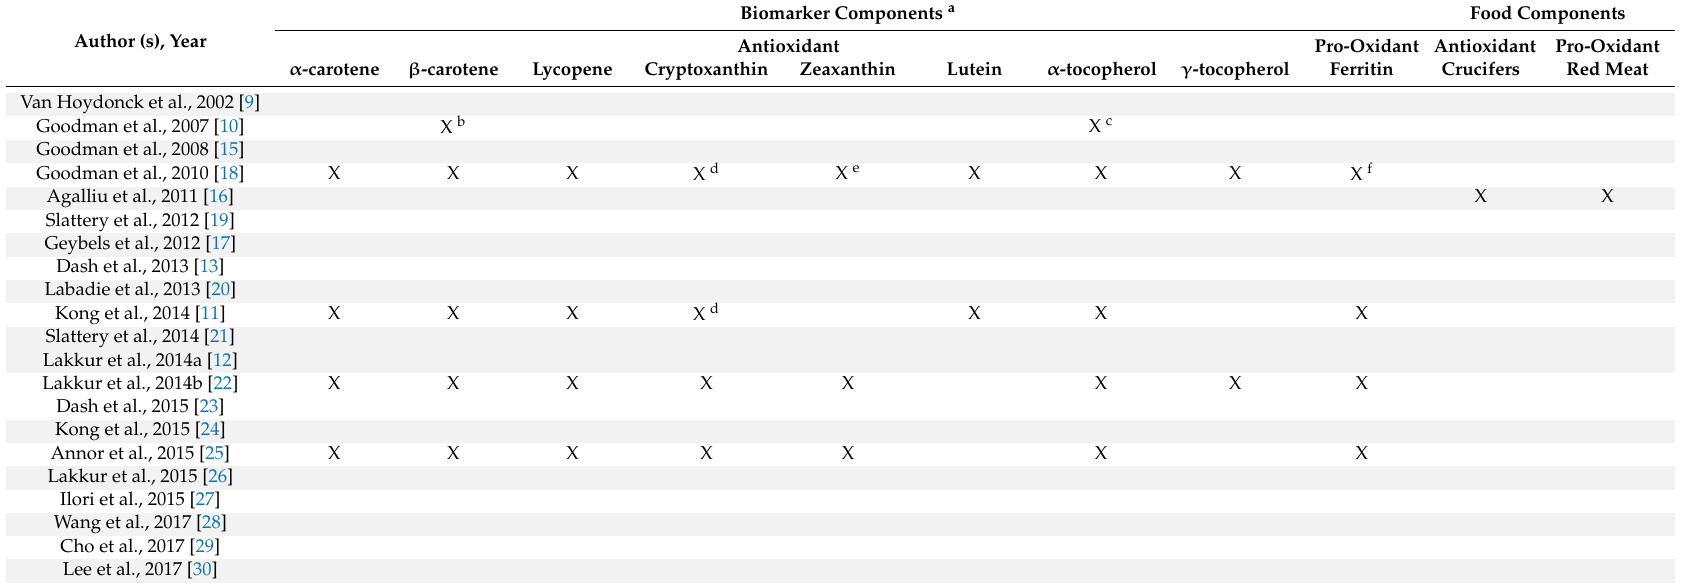
Table 4. Biomarkers and food components included in each a priori Oxidative Balance